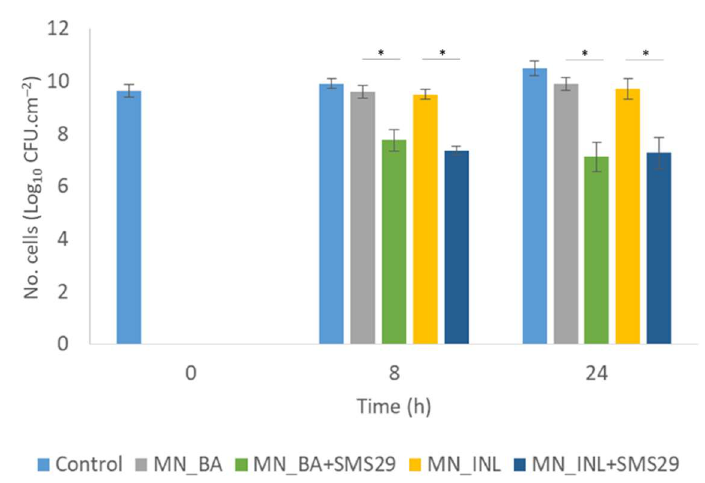
Figure 7. Evaluation of the antimicrobial efficacy of vB_PaeM-SMS29, delivered in buffer and loaded onto the INL and BA MNs, against 48 h-old P. aeruginosa PAO1 biofilms. The effect was evaluated after 8 and 24 h of treatment. * statistically significant ( p < 0.05).